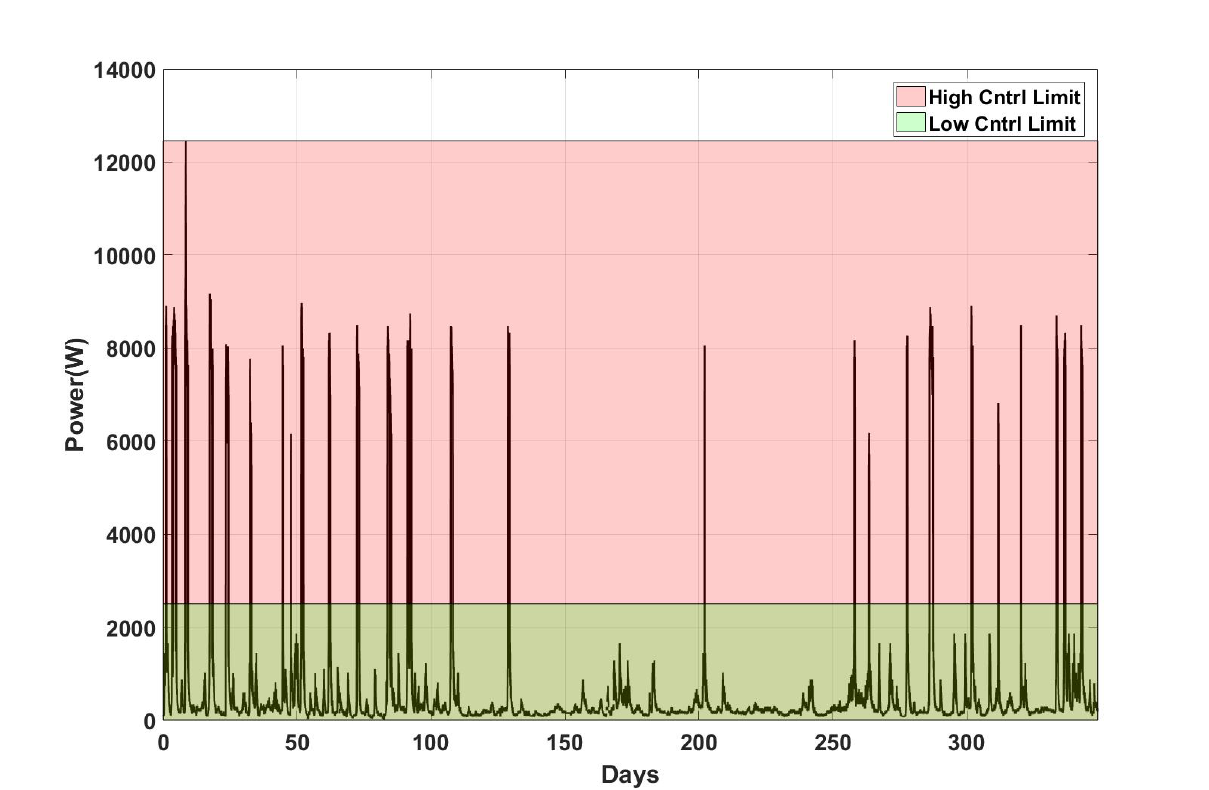
Fig. 18: The predicted power extraction of one